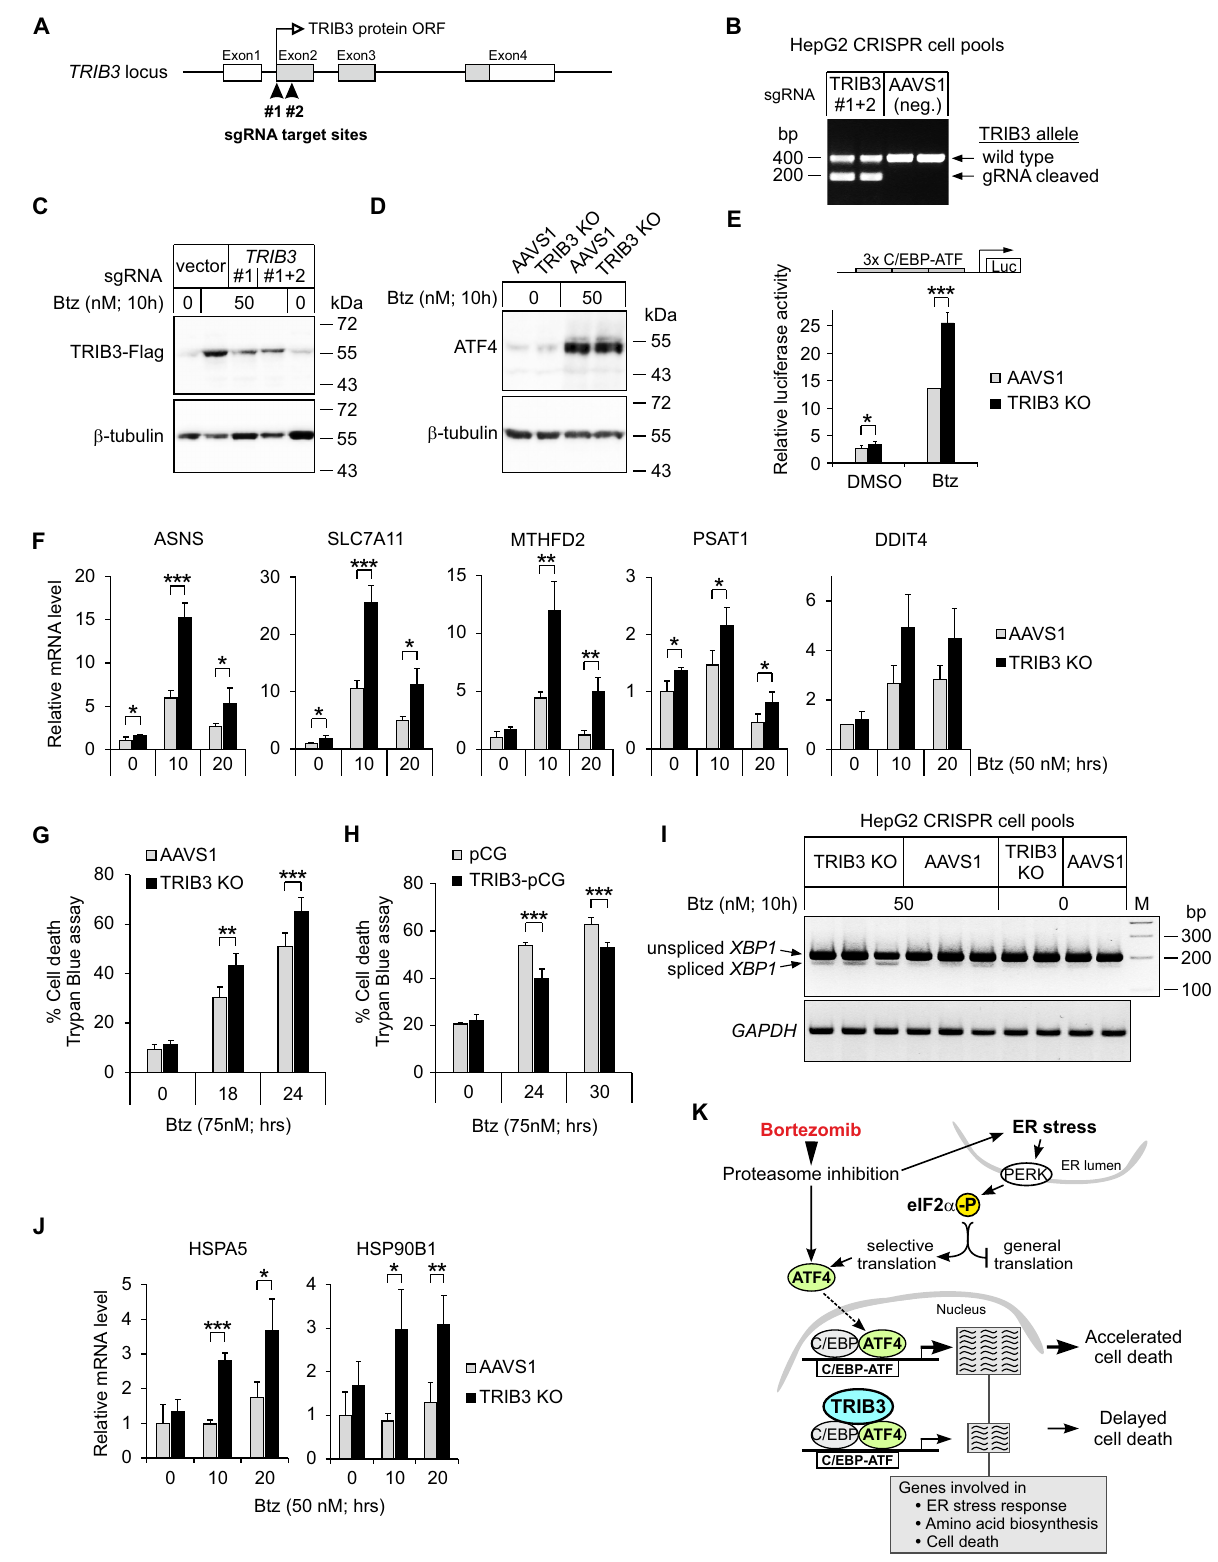
Figure 8. TRIB3 reduces ATF4 transactivation activity, lowers ER stress response levels and promotes survival of HepG2 cells exposed to bortezomib (Btz). ( A ) Schematic illustration of CRISPR/Cas9-based disruption on the human TRIB3 gene. Guide RNA target sites (#1; #2) are indicated by filled arrowheads. ( B ) PCR conformation of targeted deletion in the TRIB3 locus. Agarose gel of PCR products from HepG2 cell pools transfected with TRIB3 -specific sgRNAs (#1 and #2) or with control